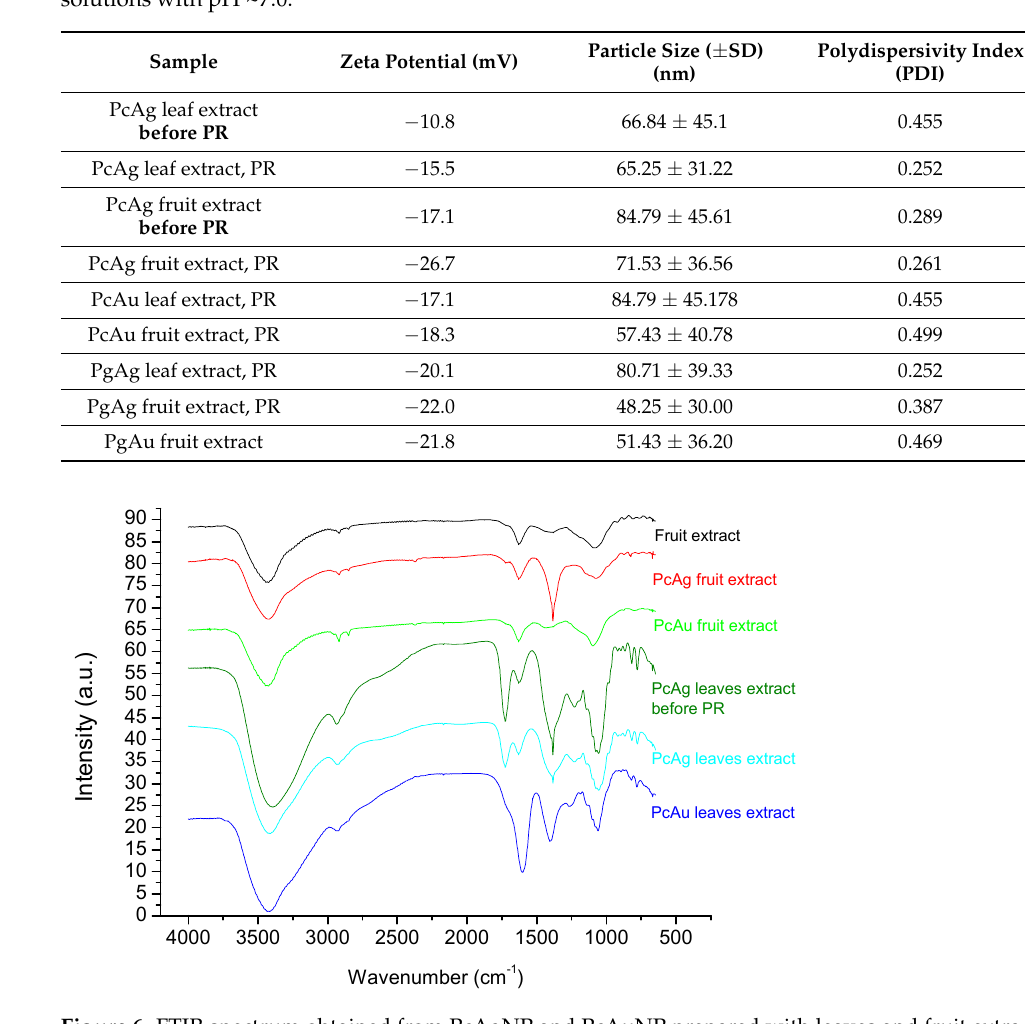
Figure 6. FTIR spectrum obtained from PcAgNP and PcAuNP prepared with leaves and fruit ex-